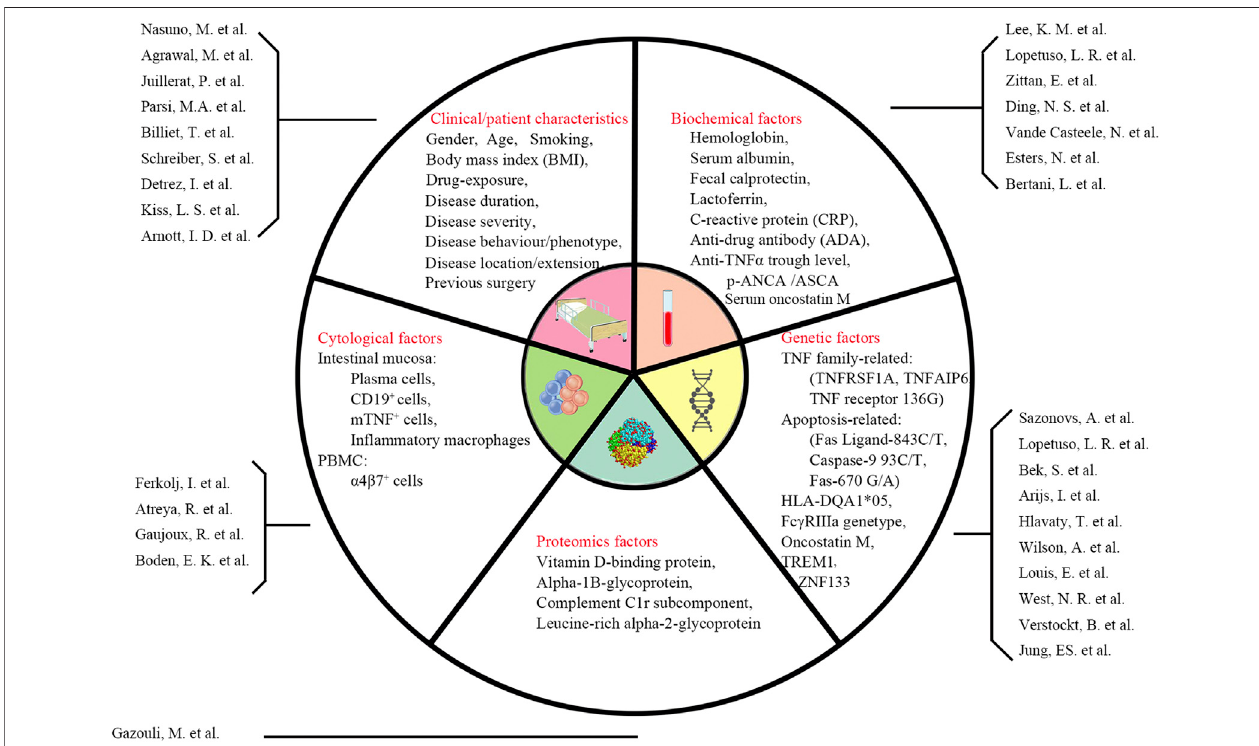
FIGURE2| Summaryofpreviouspredictorsofresponsetobiologicagents(Estersetal.,2002;Parsietal.,2002;Arnottetal.,2003;Louisetal.,2004;Ferkoljetal., 2005; Hlavaty et al., 2007; Arijs et al., 2010; Schreiber et al., 2010; Kiss et al., 2011; Gazouli et al., 2013; Lee et al., 2013; Atreya et al., 2014; Billiet et al., 2015; Juillerat etal.,2015;VandeCasteeleetal.,2015;Beketal.,2016;Detrezetal.,2016;Dingetal.,2016;Zittanetal.,2016;Lopetusoetal.,2017;Nasunoetal.,2017;Westetal., 2017; Boden et al., 2018; Gaujoux et al., 2019; Jung et al., 2019; Verstockt et al., 2019; Wilson et al., 2020; Agrawal et al., 2022; Bertani et al., 2022)